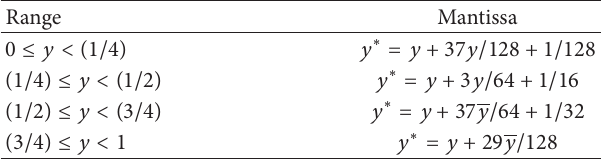
Table 3: Coefficients of 𝑎 and 𝑏 for logarithmic conversion.